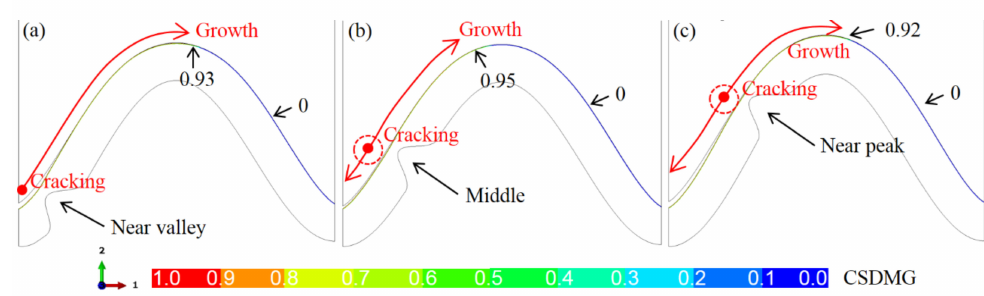
Figure 11. The CSDMG distributions in the ceramic layer under different locations of one bulge ( N = 20, at room temperature): ( a ) near the valley, ( b ) middle, and ( c ) near the peak.